Question: Write the caption for this figure.
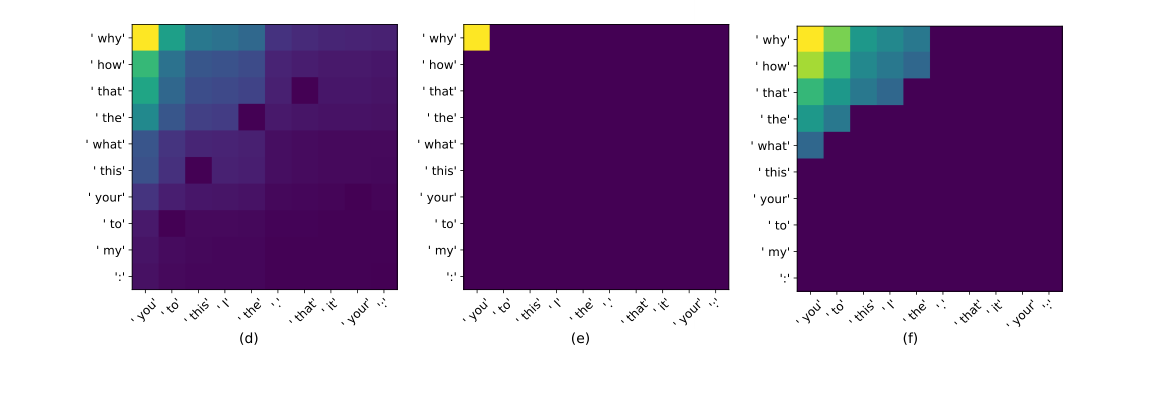
Answer: Joint probability distribution with top 10 tokens sorted in decreasing order of probabilities using the DynaMo-2.9B-T2 model for the input prompt: Please explain. Probabilities corresponding to repetition have been penalized by a factor of 100. (a) and (d) are vanilla distributions. Co-occurrence masked distribution with (b) αc = 0.5 [CO-0.5] and (c) αc = 1.0 [CO]. Adaptive thresholding (e) without Gaussian blur [AT], and (f) with Gaussian blur (kernel size = 3) [AT + G-3].